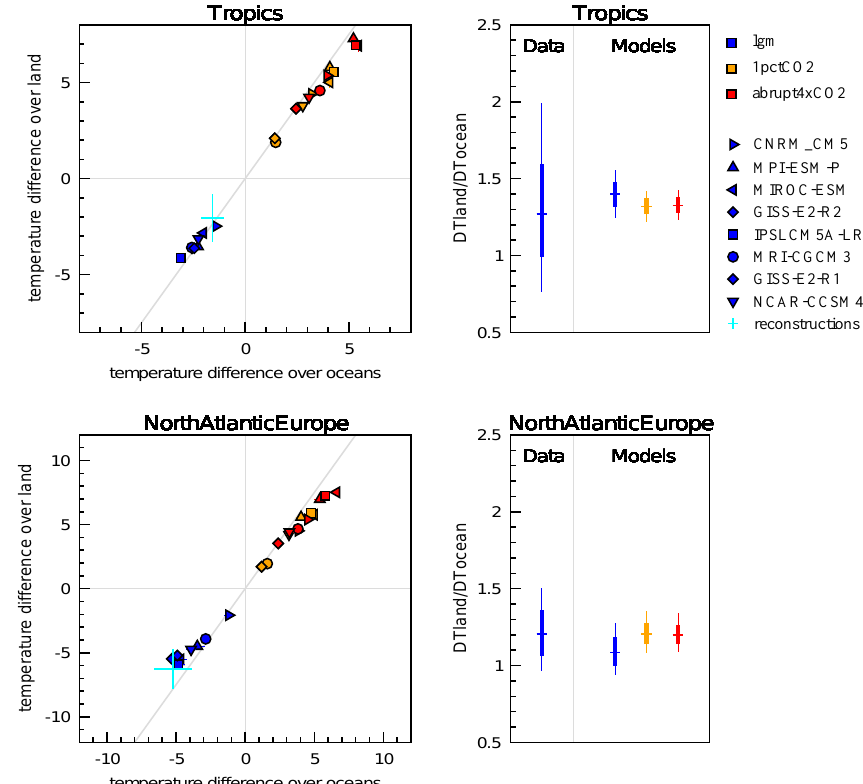
Fig. 2. Left panels: average surface air temperature change, compared to piControl, over land compared to over the oceans for the tropics (23 ◦ S–23 ◦ N) and the North Atlantic and Europe region (45 ◦ W–90 ◦ E, 35–45 ◦ N). LGM – piControl in blue, 1pctCO2 – piControl in orange, abrupt4xCO2 – piControl in red. For the latter 2 periods, the averages have been computed over the same years as Fig. 1. The results have been computed for all models in the database on 23 July 2012 for which there were results for the lgm, piControl, 1pctCO2 and abrupt4xCO2. The grey lines indicate the 1:1.5 ratio in both plots. The results from the reconstructions are based on the MARGO (2009) data for the oceans and on the Bartlein et al. (2011) data for the continents. The error bars show twice the standard deviation of the distribution of the mean temperature changes over the region, as estimated by the same bootstrap method as described for the bottom-left plot of Fig. 1 and in Sect. 3.1. Right panels: plots show the land-sea ratio computed from the data, again with the same bootstrap method. The horizontal bar shows the median ratio, the thick vertical line shows the 25–75th percentiles and the thin lines the 10–90th percentiles. The model results are computed by a bootstrap method applied on all model results, as explained in the text. The definition of the thin/thick vertical lines and horizontal bar are the same as for the